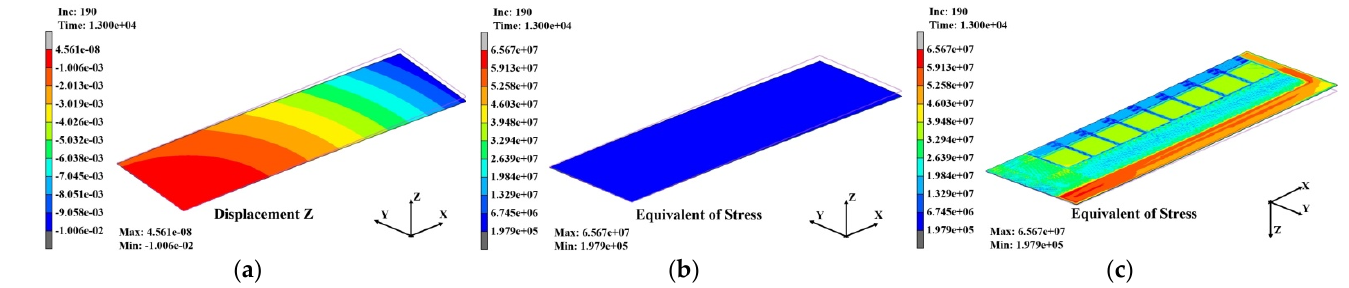
Figure 20. Analysis results of the substrate after SR laminating: ( a ) warpage distribution (10.06 μ m); ( b ) stress distribution (65.7 MPa); ( c ) stress distribution at bottom view (65.7 MPa).